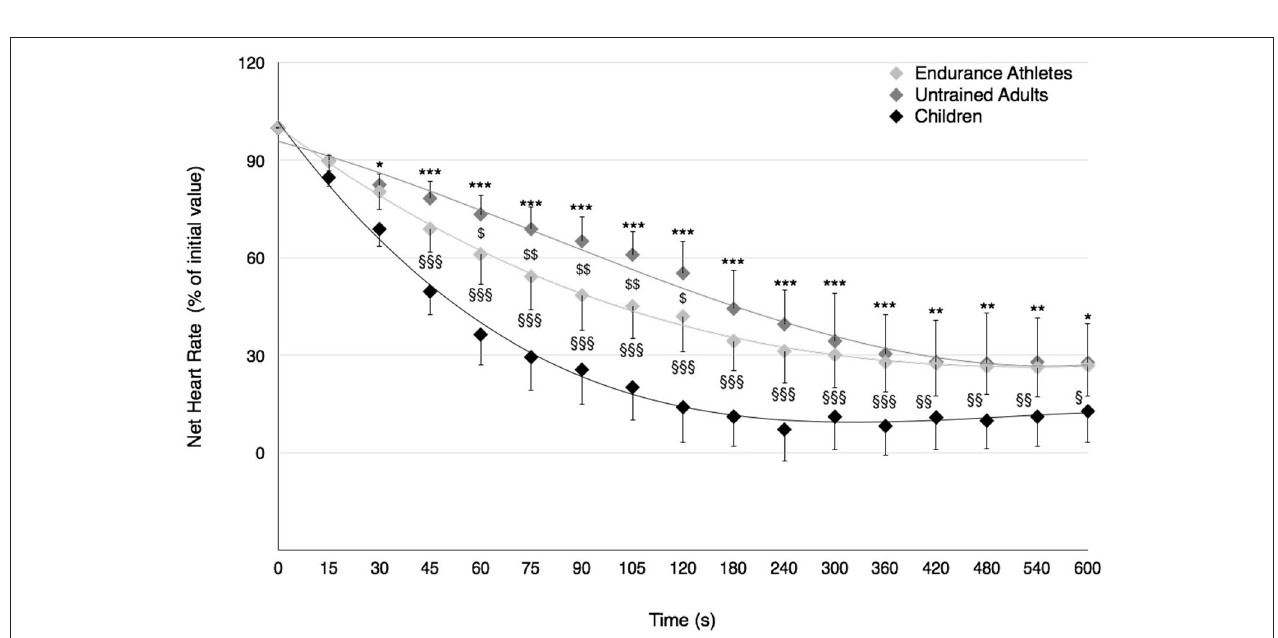
FIGURE 3 | Recovery of net heart rate after the Wingate test in prepubertal children, untrained adults, and well-trained adult endurance athletes. Values were expressed as percentage of initial values. *, **, ***Significantly different at p < 0.05, p < 0.01, and p < 0.001, respectively, between children and untrained adults. $ , $$ Significantly different at p < 0.05 and p < 0.01, respectively, between untrained adults and well-trained adult endurance athletes. § , §§ , §§§ Significantly different at p < 0.05, p < 0.01, and p < 0.001, respectively, between children and well-trained adult endurance